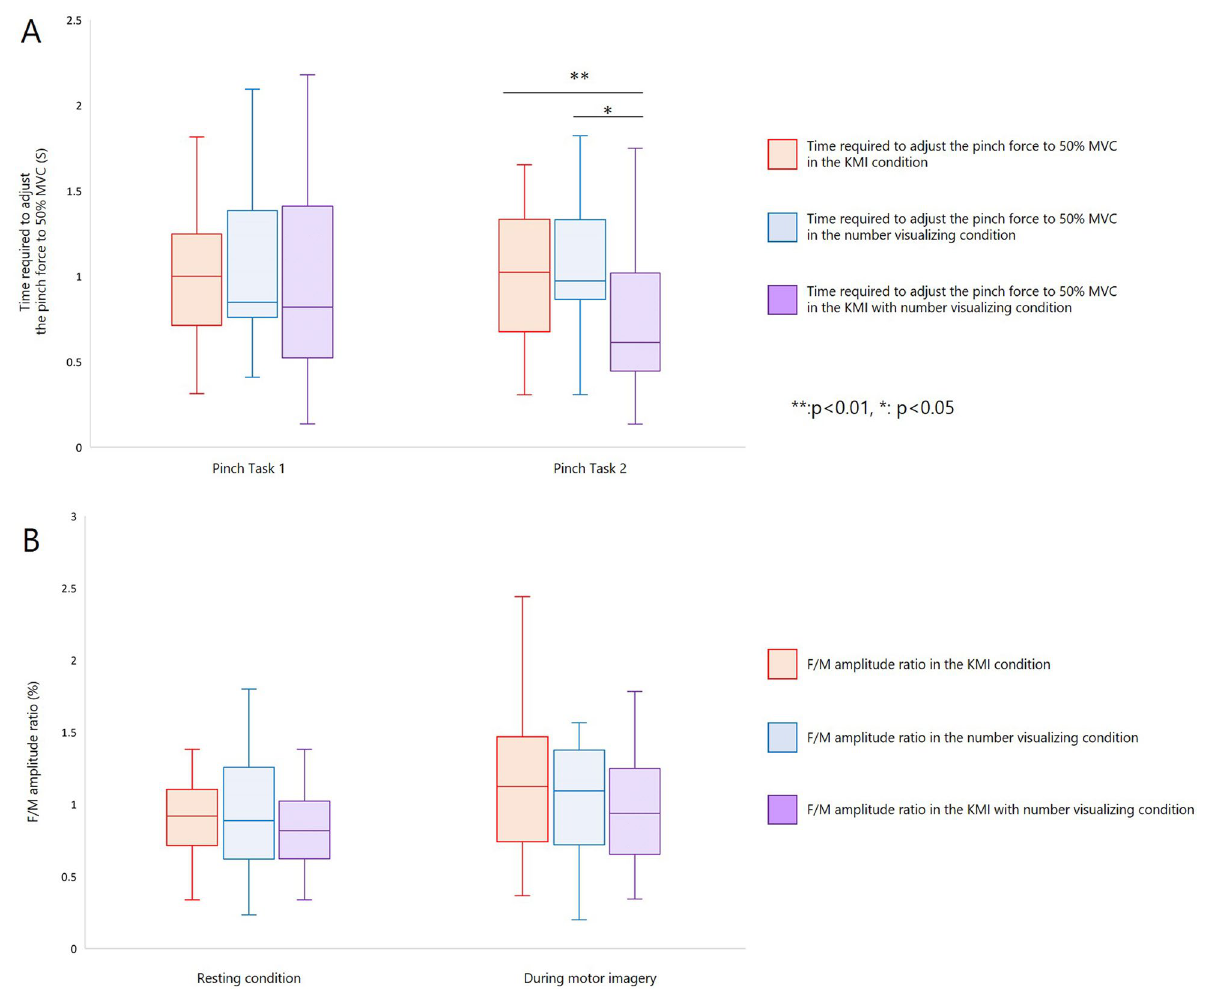
Figure 2. Comparison between each motor imagery strategy. (A) There were no differences in the time required to adjust the pinch force to 50% of maximum voluntary contraction (MVC) in pinch task 1 between the KMI, number visualizing, and KMI with number visualizing (Friedman’s test: DF = 2, p = 0.717). This confirmed that participants were able to properly perform the task under the relevant condition without being affected by the previous condition. There was a difference in the time required to adjust the pinch force to 50% MVC in pinch task 2 among the KMI, number visualizing, and KMI with number visualizing (Friedman’s test: DF = 2, p = 0.001). Moreover, the time required to adjust the pinch force to 50% MVC was shorter in the KMI with number visualizing condition than in the KMI condition (Wilcoxon signed-rank test: r = 0.73, p = 0.003). The time required to adjust the pinch force to 50% MVC was shorter for the KMI with number visualizing than in the number visualizing condition (r = 0.57, p = 0.030). ( B ) There were no differences in the F/M amplitude ratios between each MI condition at rest (Friedman’s test: DF = 2, p = 0.842) and during MI (Friedman’s test: DF = 2, p =